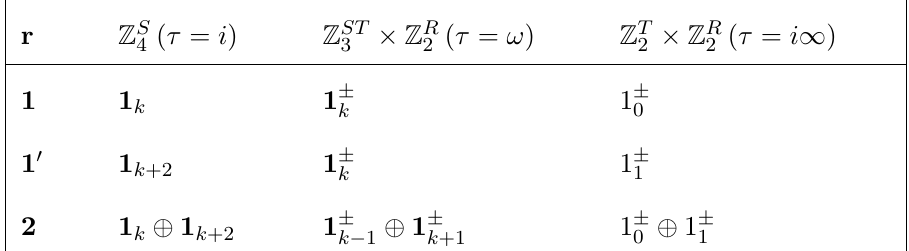
’ S 3 under the residual symmetry 2